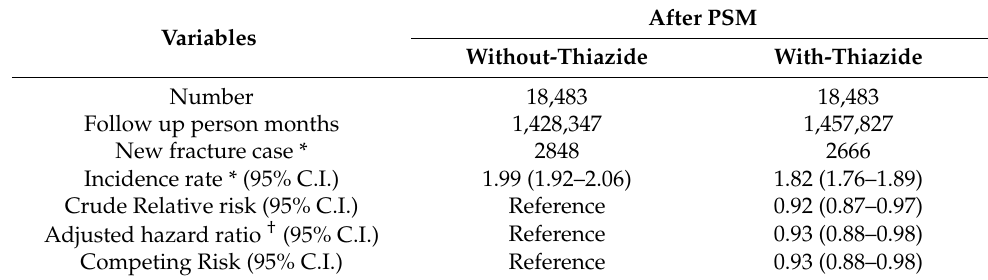
Table 2. Incidence density of fracture.